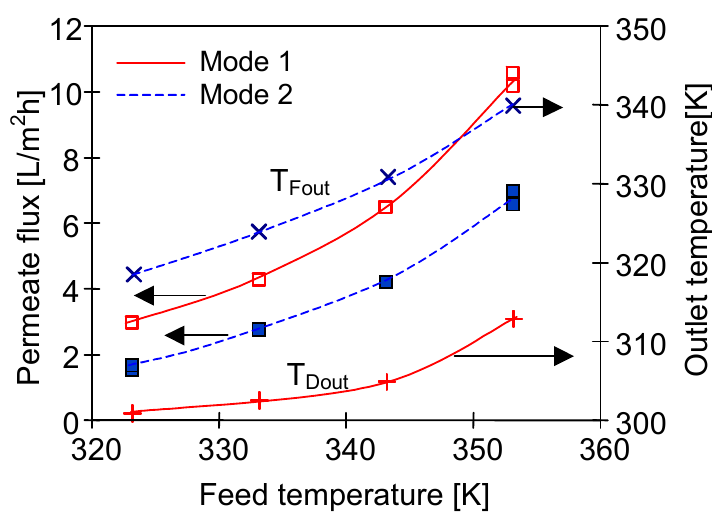
Figure 5. The influence of feed temperature and direction of feed flow (Mode 1 or Mode 2) on the permeate flux and outlet temperature of feed or distillate. Module SMD1. Flow rate inside the capillaries v = 0.62 m/s. Distillate inlet temperature 293 K.